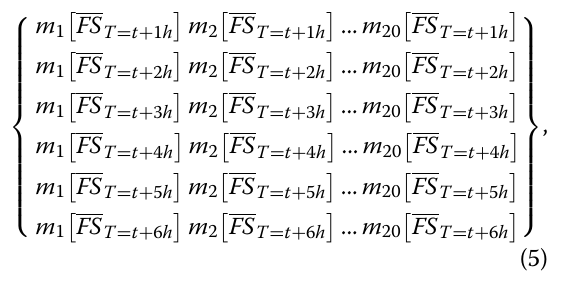
Table 1 Error matrix